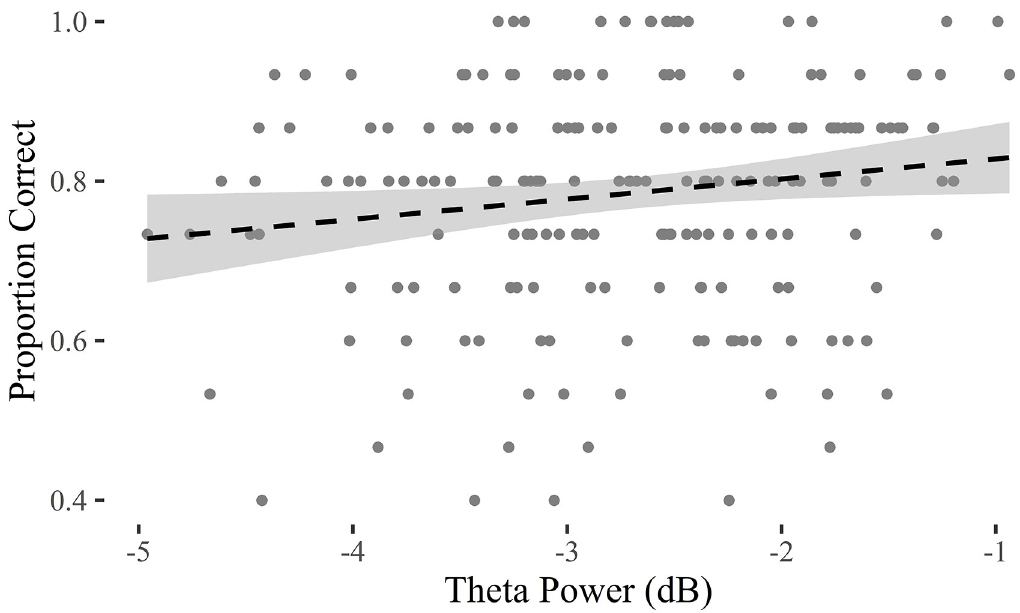
Fig 4. Image-by-image correlation between induced Theta power (x-axis) and the proportion of correct responses (y-axis) at the memory test. Least squares linear fit and its confidence interval are shown with the dashed line and shaded area,